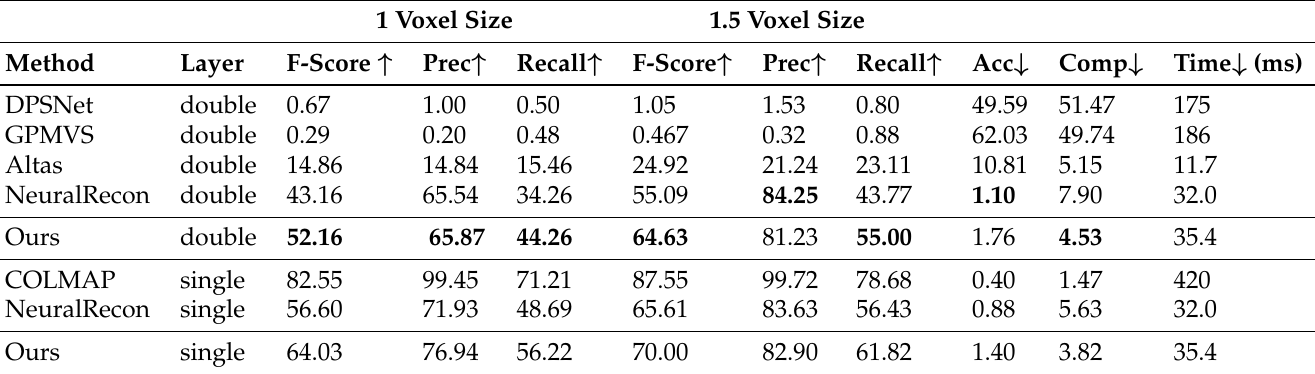
Table 3. The 3D reconstruction accuracy of different methods. The 1 voxel size and 1.5 voxel size represent the value of the corresponding threshold when calculating Prec and Recall. The method of calculating metric values are the same as Atlas [11] and NeuralRecon